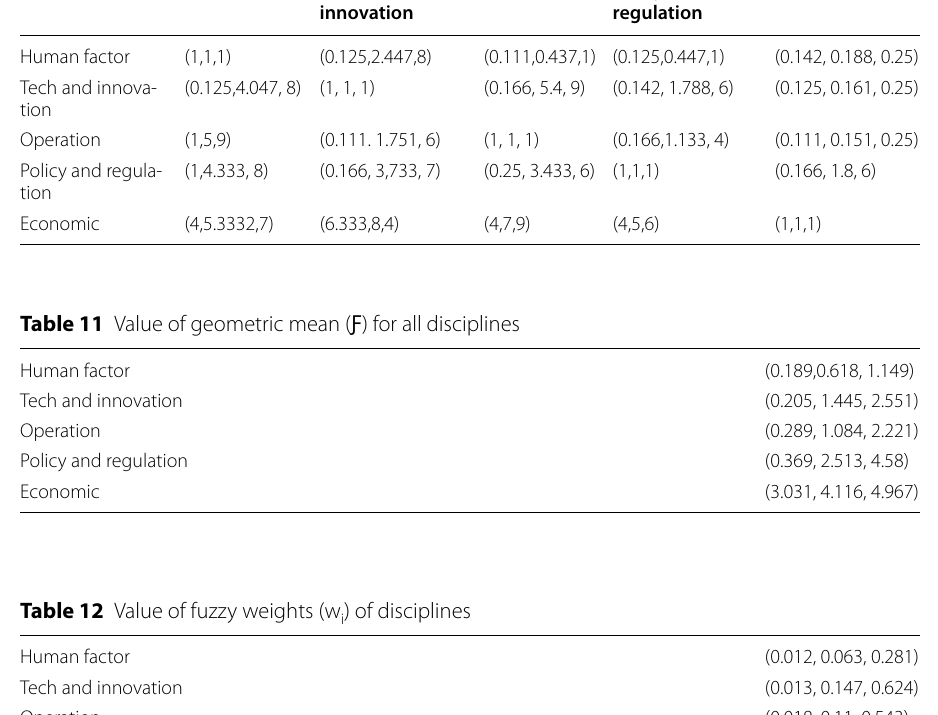
Table 10 Aggregated fuzzy comparison matrix of aspects Criteria